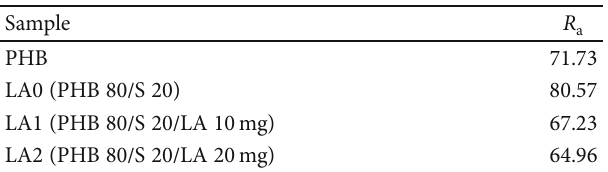
Table 2: Surface roughness ( R (at 50.0 μ